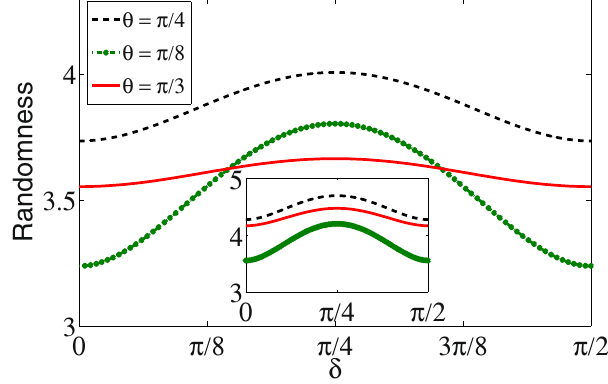
Figure 2. Intrinsic randomness in position space as a function of initial state parameter δ after 25 step of walk using different coin operation parameter θ . It is evident from the figure that randomness shows some dependency on the initial state, however, the variation is very small when compared to the zero randomness in the initial stage. Inset in the figure is the randomness when both coin and position space are taken together. We see a unit increase in the randomness when both the space are taken into